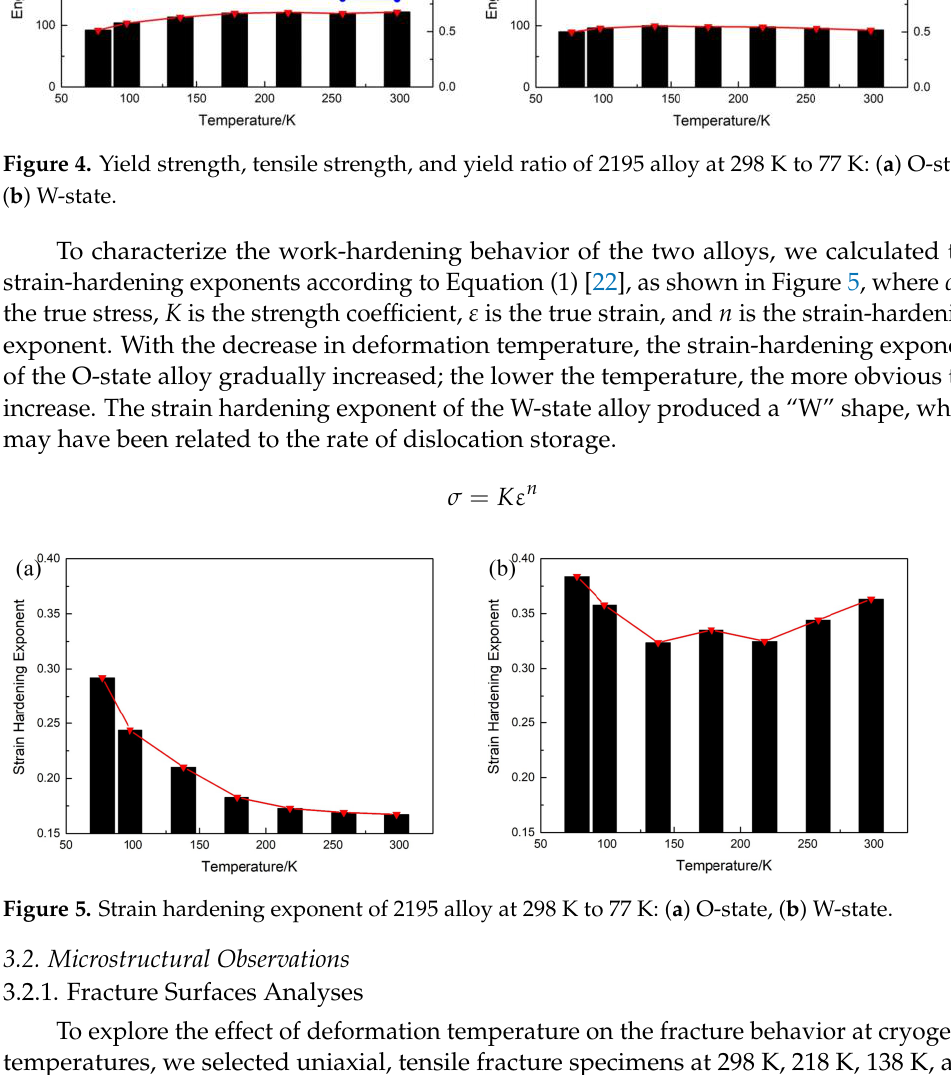
Figure 5. Strain hardening exponent of 2195 alloy at 298 K to 77 K: ( a ) O-state, ( b ) W-state.